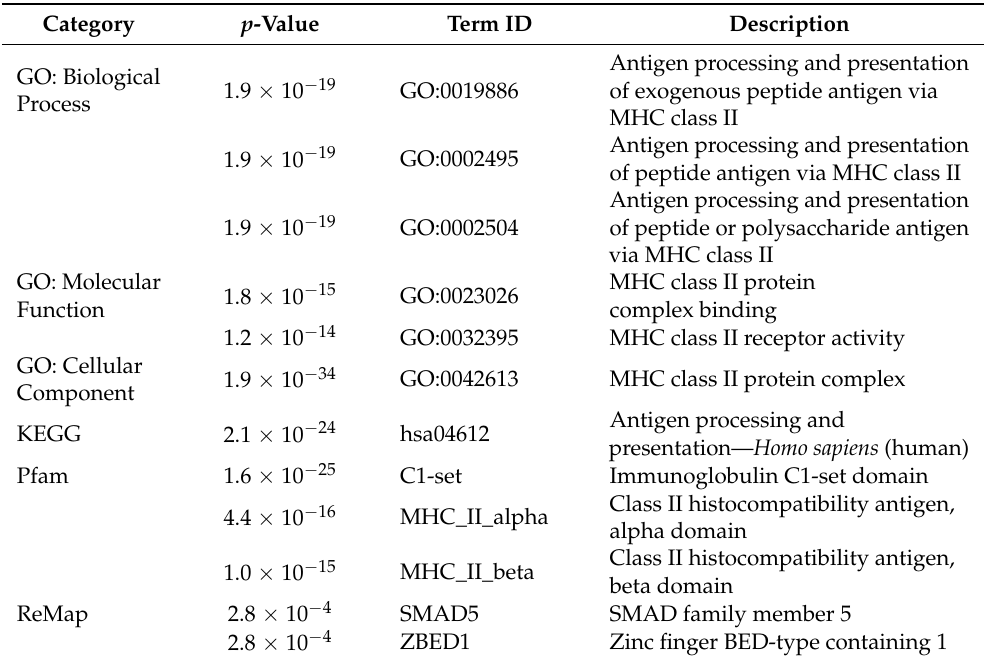
Table 3. Selected top gene term enrichments of the coexpressed genes to HLA-DMA in